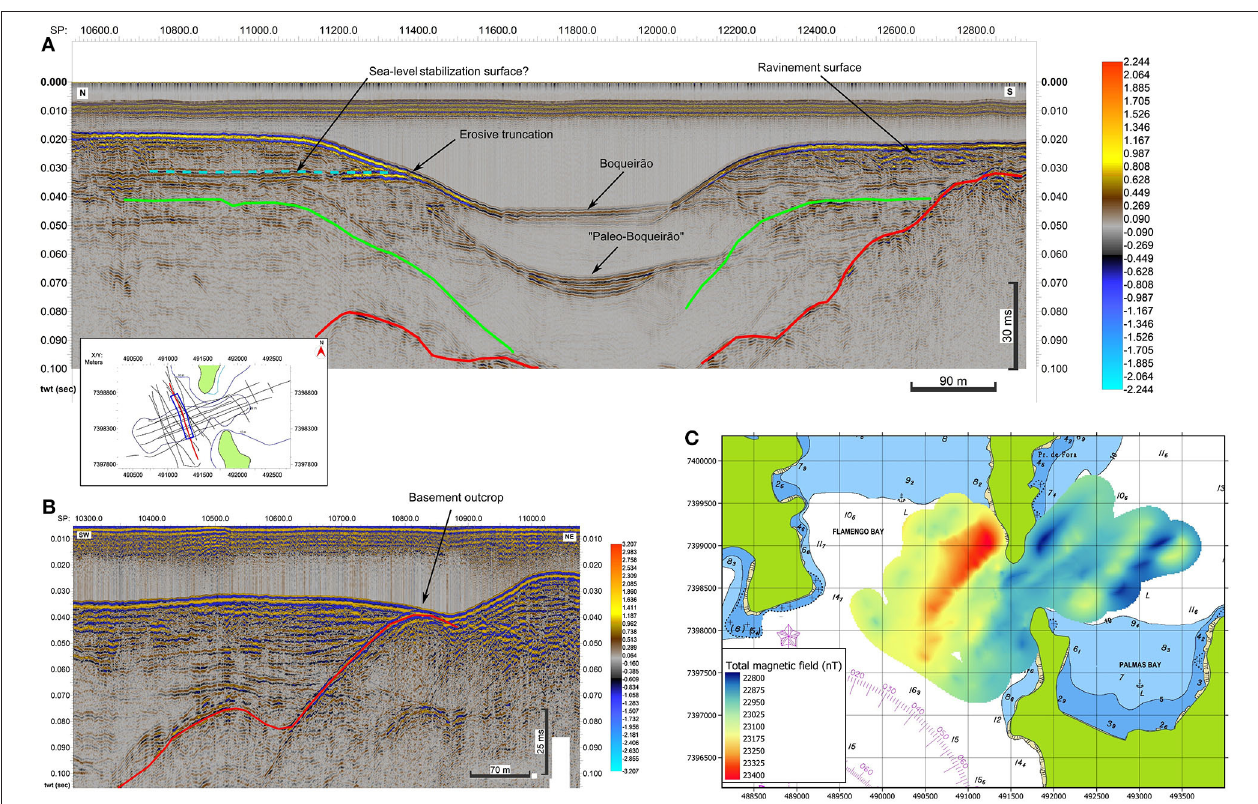
FIGURE 2 | (A) Seismic line N–S oriented, showing the crystalline basement (red mapped reflector), the present seabed, and an ancient position of the seabed. In green, the seabed multiple. Vertical exaggeration of approximately three times; (B) seismic line SW–NE oriented, showing the outcrop of the crystalline basement (red mapped reflector) and the divergent reflections onto it. Vertical exaggeration of approximately three times; (C) total magnetic field in nT obtained in the Flamengo Bay